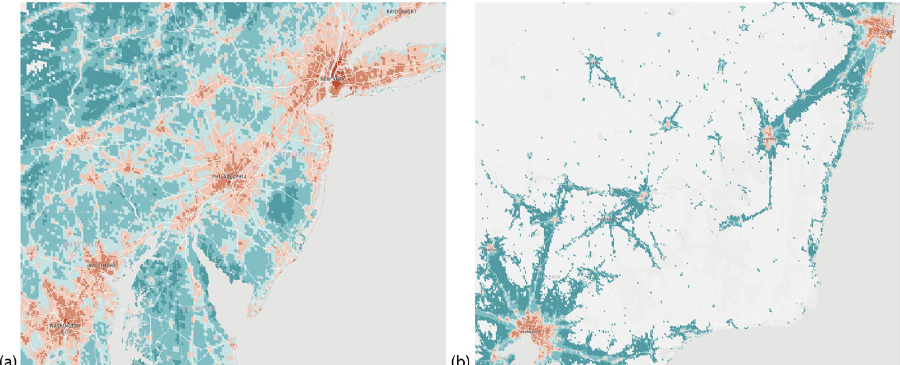
Fig. 1 Snapshot of AMM. a Northeastern United States and b Southeastern Australia. Color of each 5 km 2 cell corresponds to the annual average of total out fl ow volume in logarithmic scale (warmer colors imply higher connectivity). Note the variations in sparsity and total connectivity. Data are shown in the spatial resolution of cells, although for our subsequent analyses we use AMM aggregated to counties/states to match the surveillance data. Further, for the United States the study is performed at city (New York) and state (NY and NJ) scales, whereas for Australia the study is performed at a national scale, highlighting the versatility of the